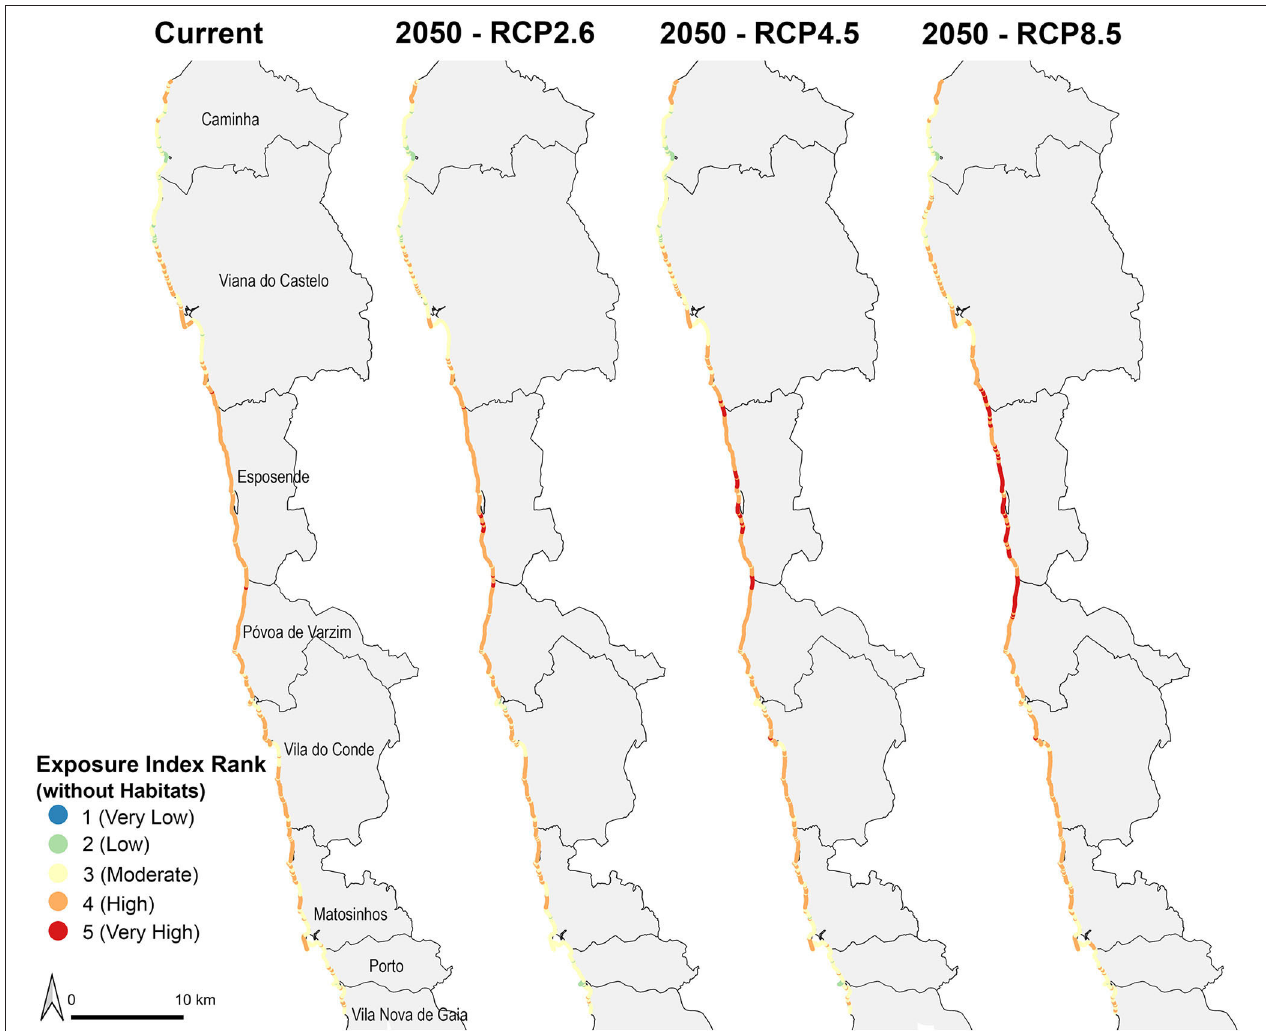
FIGURE 5 | Exposure Index values for the Current scenario and under the different RCP scenarios for 2050 for the northern coast of Portugal, without the contribution of coastal habitats. RCP, Representative Concentration Pathway.